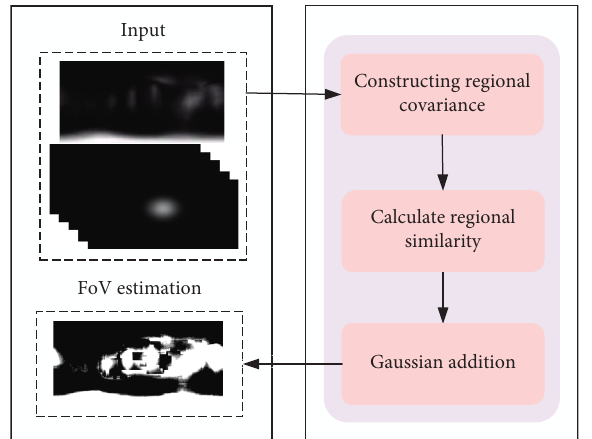
Figure 4: Viewport estimation based on saliency and limited FoV